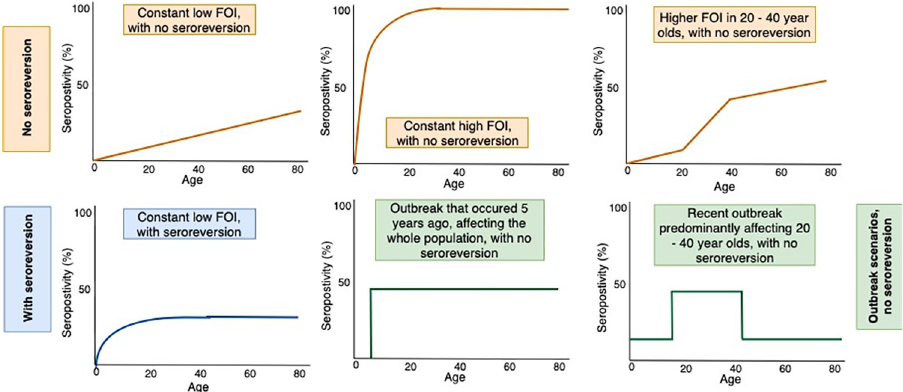
Fig 1. Schematic representations of different possible seroprevalence profiles by age that could be observed, depending on underlying epidemic and immunological dynamics.